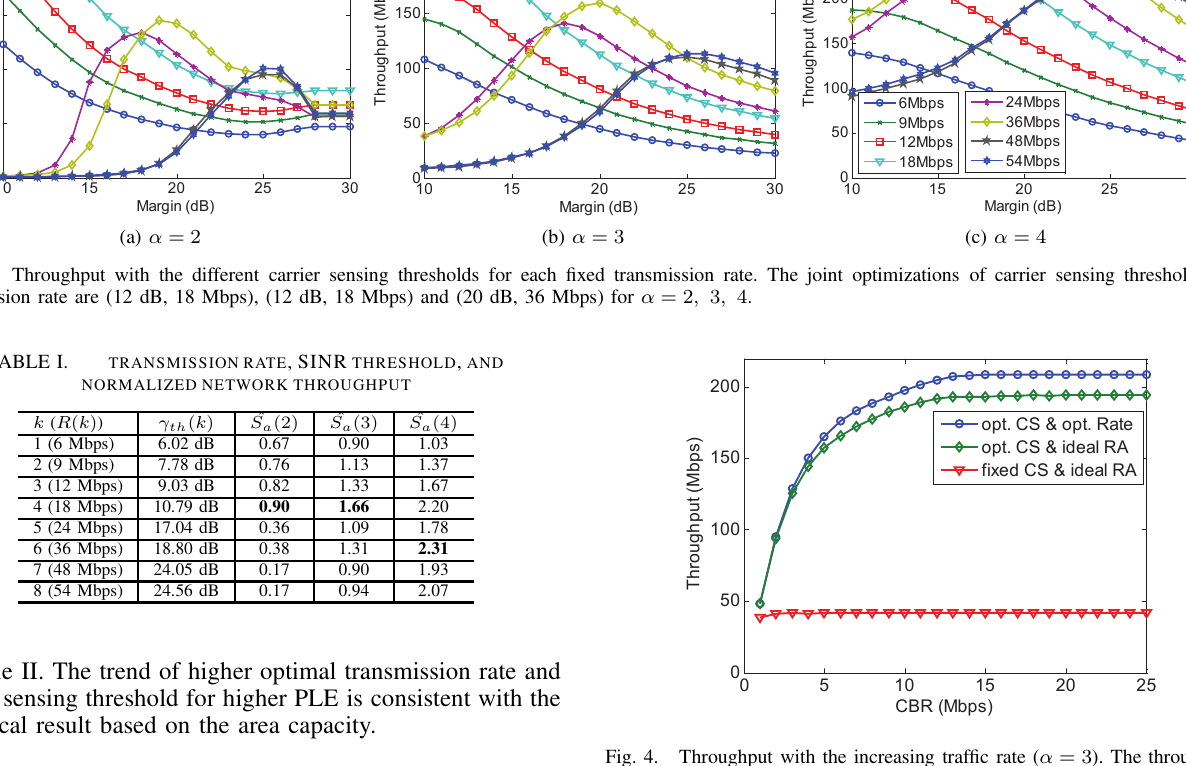
OPTIMAL TRANSMISSION RATE , CARRIER SENSING THRESHOLD AND NORMALIZED AREA THROUGHPUT